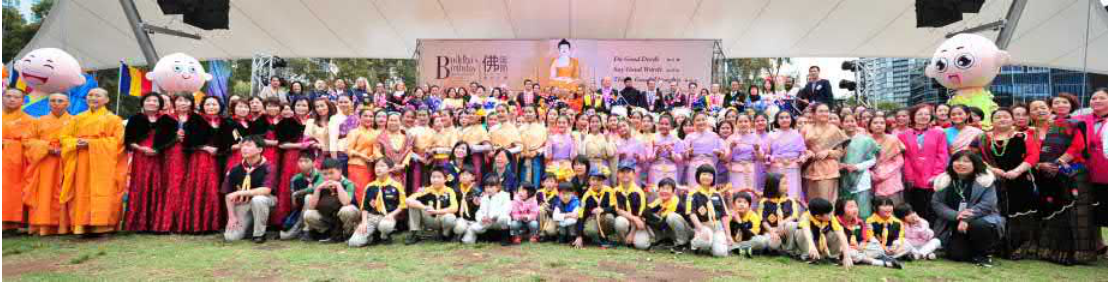
Figure1: Monastics, dignitaries, interfaith representatives, performers, volunteers, Three Acts of Goodness mascots, young and old gathered for a group photograph at the Buddha’s Birthday Festival in Darling Harbour, Sydney, Australia in year 2018 (courtesy Nan Tien Temple